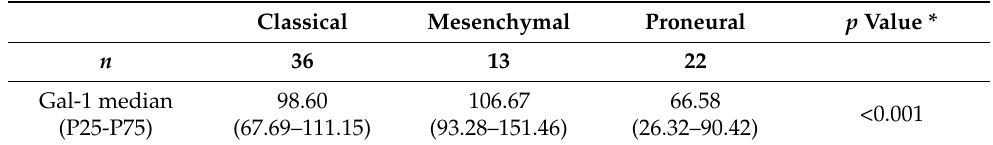
Table 3. Correlation between Gal-1 expression and GBM molecular subtypes using the combined H-score.